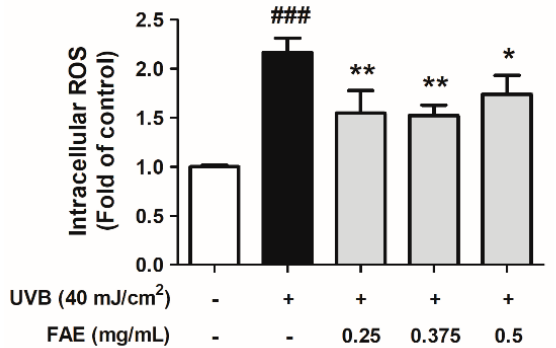
Figure 3. Inhibitory effects of Ficus awkeotsang Makino extract (FAE) on production of intracellular reactive oxygen species (ROS) in UVB-irradiated Hs68 cells. Significant difference with control (white bar): ### p < 0.001; significant difference with UVB-exposure group (black bar): * p < 0.01, ** p < 0.05. Tukey’s HSD test was used to determine statistical significance. n = 3; all error bars represent the standard deviation of the mean.